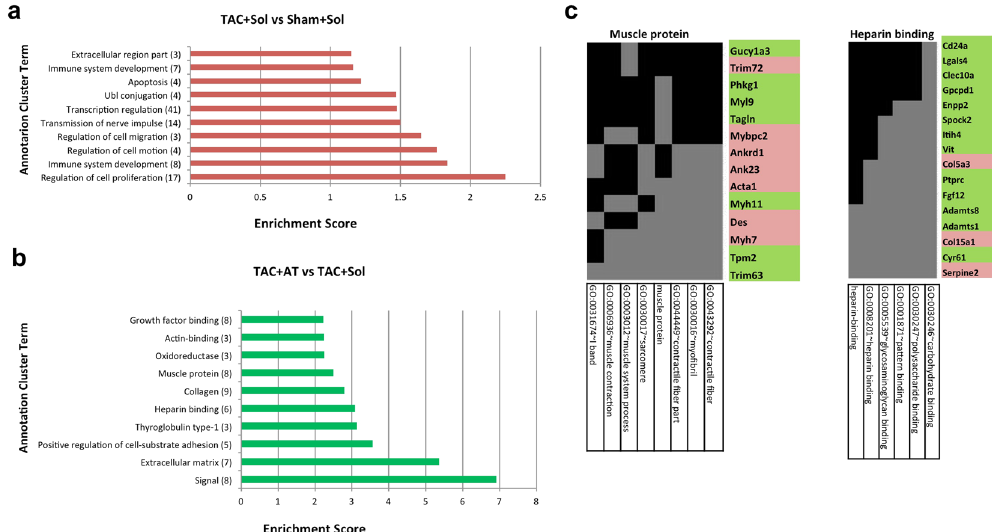
Figure 3. Biological implications based on functional annotation gene clustering. Function annotation clusters identified by DAVID of differentially expressed genes between ( a ) TAC + Sol and Sham + Sol or ( b ) TAC + AT vs TAC + Sol. Annotation clusters were identified using default settings with medium stringency. Beside each annotation is the number of representative terms associated within each cluster. ( c ) Two representative clusters from TAC + AT vs TAC + Sham. Representative terms within each cluster are on the X axis. Genes within each GO term are on the Y axis. Left: ‘Muscle protein’ (7 genes up, 7 down, 14 total). Right ‘Heparin binding’ (3 up genes, 13 down, 16 total). Grey indicates association of a gene with a representative term. Genes shaded red or green were up- or down-regulated,